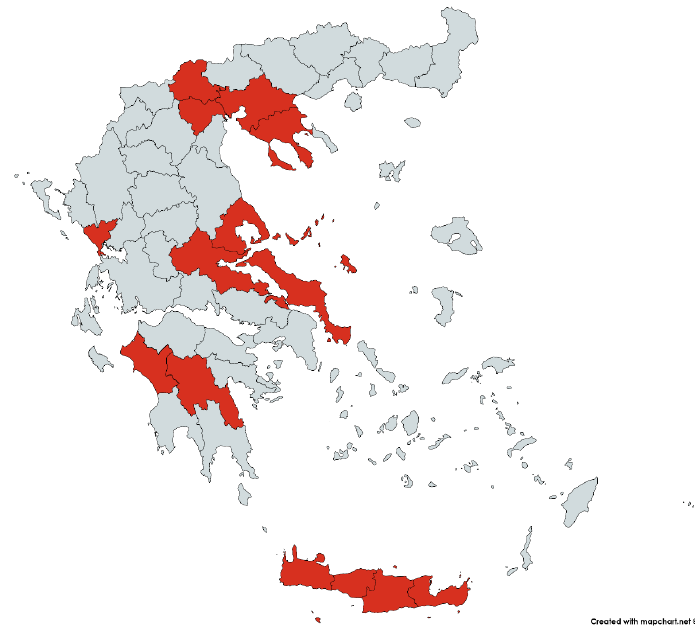
Figure 1. Regions with intense tomato production (Source: based on data from Hellenic Statistical Authority (ELSTAT) [56]).